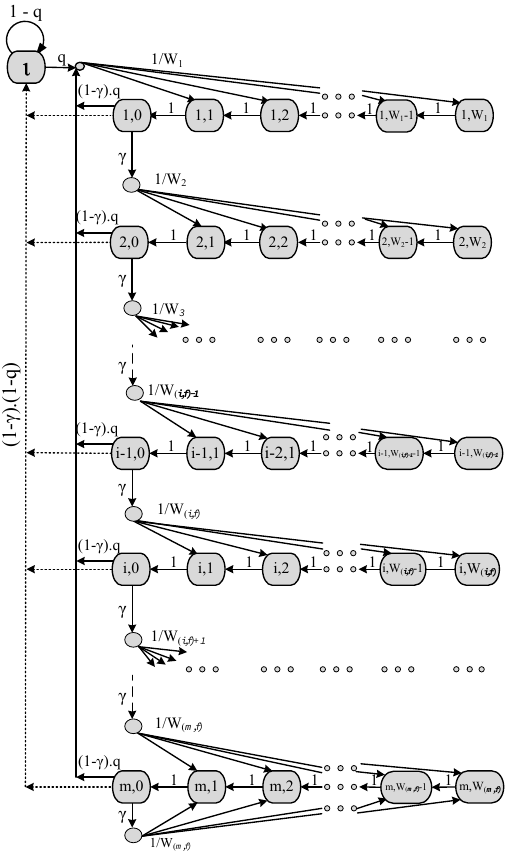
Figure 9. DTMC for the non-saturation behavior of the PFB-based WBAN CSMA/CA